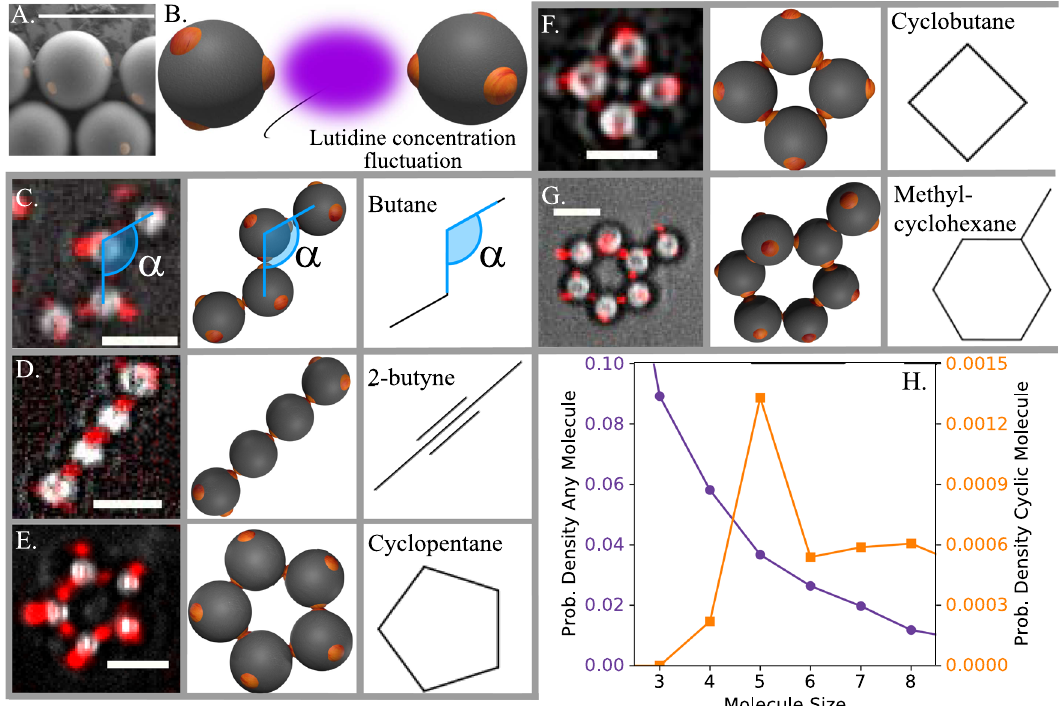
Fig. 1 Colloidal molecules assembled by critical Casimir forces. A Scanning electron microscope (SEM) image of tetramer patchy particle with patches coloured yellow. Scale bar corresponds to 5 μ m. B Schematic of the directed critical Casimir interaction: lutidine fl uctuations con fi ned between hydrophobic patches cause patch-to-patch attraction. C – G Examples of colloidal molecules: colloidal butane ( C ), 2-butyne ( D ), cyclopentane ( E ), cyclobutane ( F ), and methylcyclohexane ( G ), confocal superimposed onto bright- fi eld microscope images highlighting patches in red (left), schematic reconstruction (middle) and chemical representation (right). In C , the characteristic tetrahedral bond angle α = 109.5° is indicated. In D , the linearly connecting dipatch particles mimic sp hybridized carbon atoms, which in the colloidal analogue link both dipatch and tetrapatch particles. H Probability of occurrence of colloidal molecules as a function of their size. Purple circles (left axis) show all molecules, while orange squares (right axis) show cyclic molecules only. Clearly, larger molecules are increasingly rare, while among the cyclic structures, fi ve-particle compounds, such as cyclopentane, are most frequently observed. Data were gathered from 163,178 clusters in 457 frames. Source data are provided as a Source data fi